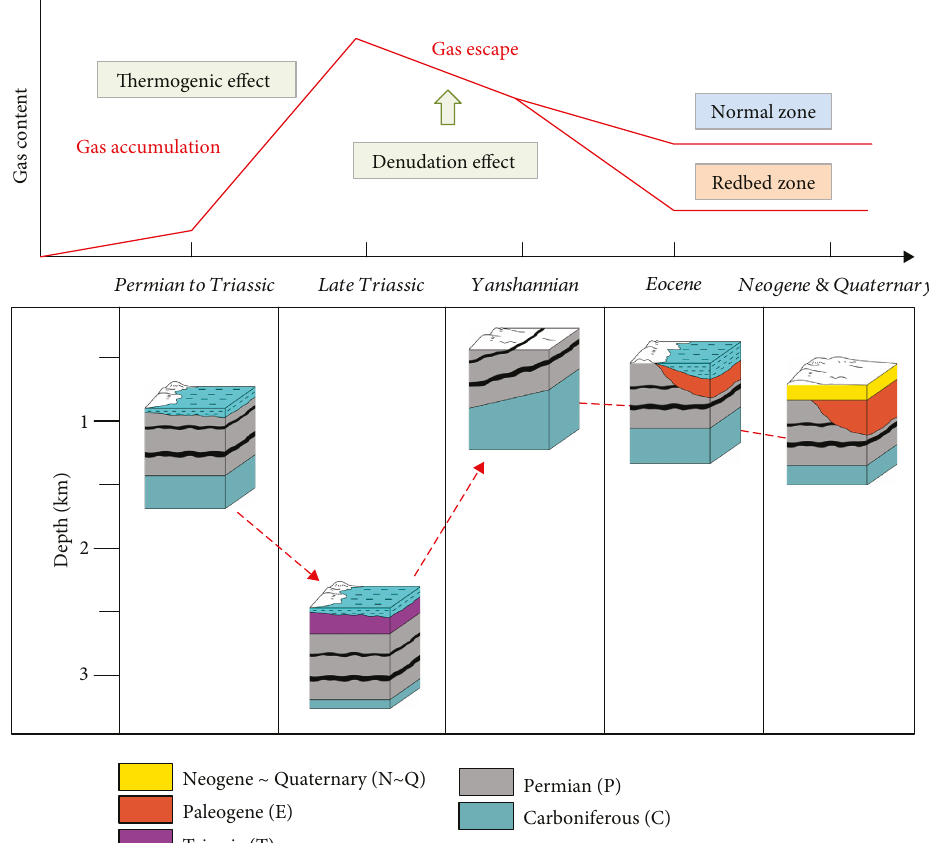
Figure 10: Schematic diagram exhibiting the stratigraphic evolution of the coal-bearing strata and the CBM accumulation process in the Xutuan coal mine. This is modi fi ed from Jin et al.